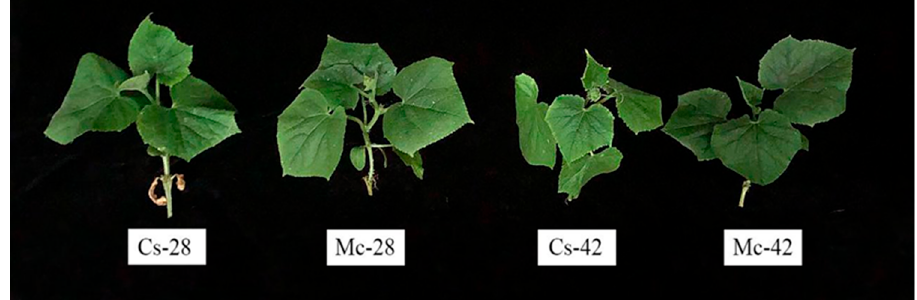
Figure 1. Interactive e ff ects of bitter melon rootstock and grafted cucumber seedlings on the phenotype of cucumber seedlings after 7 days of heat stress. Self-grafted plants treated with 28 ◦ C / 18 ◦ C (day / night), Cs-28; bitter-melon-grafted plants treated with 28 ◦ C / 18 ◦ C (day / night), Mc-28; self-grafted plants treated with 42 ◦ C / 32 ◦ C (day / night), Cs-42; bitter-melon-grafted plants treated with 42 ◦ C / 32 ◦ C (day / night), Mc-42.